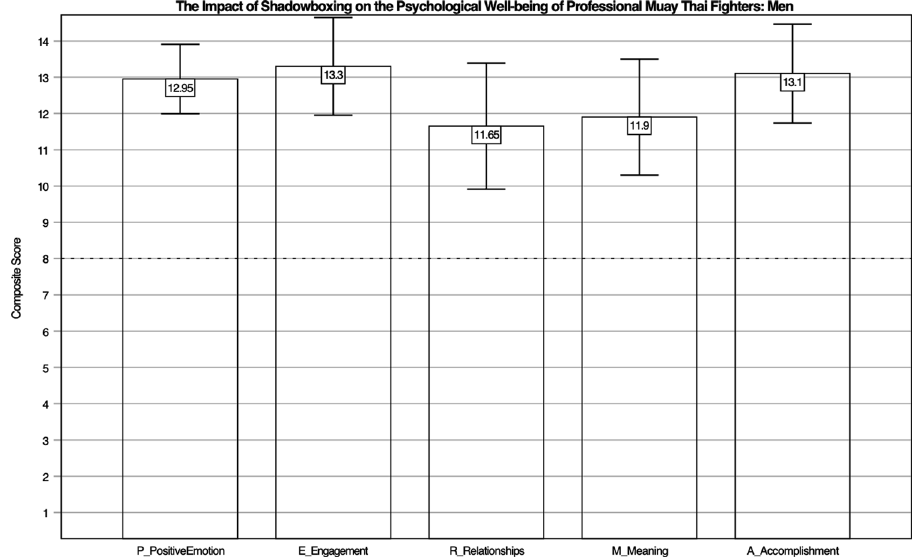
Fig. 2 This figure provides a bar plot with 95% confidence intervals (CIs) for composite PERMA scores: men (n = 10). For each element of psychological well-being, the lowest possible composite score is 2 representing that professional Nak Muays strongly agree that shadow- boxing negatively impacts that element of psychological well-being, whereas the highest possible composite score is 14 representing that professional Nak Muays strongly agree that shadowboxing positively impacts that element of psychological well-being. A composite score of 8 (dotted line) reflects a neutral position on whether shadowboxing contributes positively or negatively to that element. Results in this figure show that male Nak Muays strongly agree that shadowboxing positively contributes to all elements of their psychological well-being. Further, results in this figure show that shadowboxing contributes to the elements of psychological well-being in the following rank-order for men: engagement (E), accomplishment (A), positive emotions (P), meaning (M), and relationships (R)